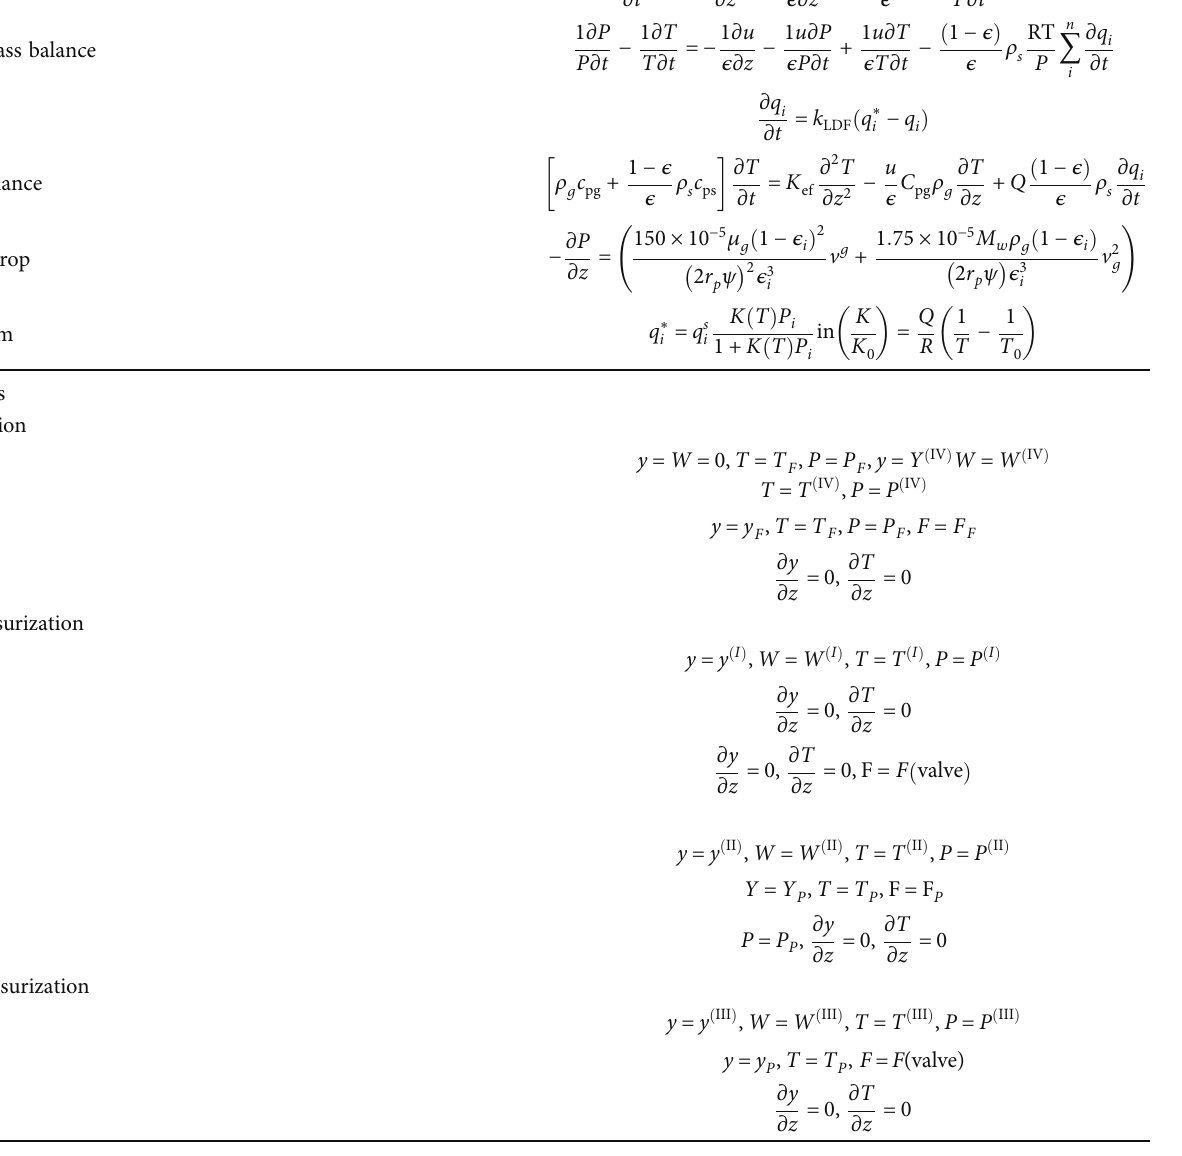
Table 5: Governing equations and simpli fi cations for production and puri fi cation of bioethanol. Mass balance for adsorbing